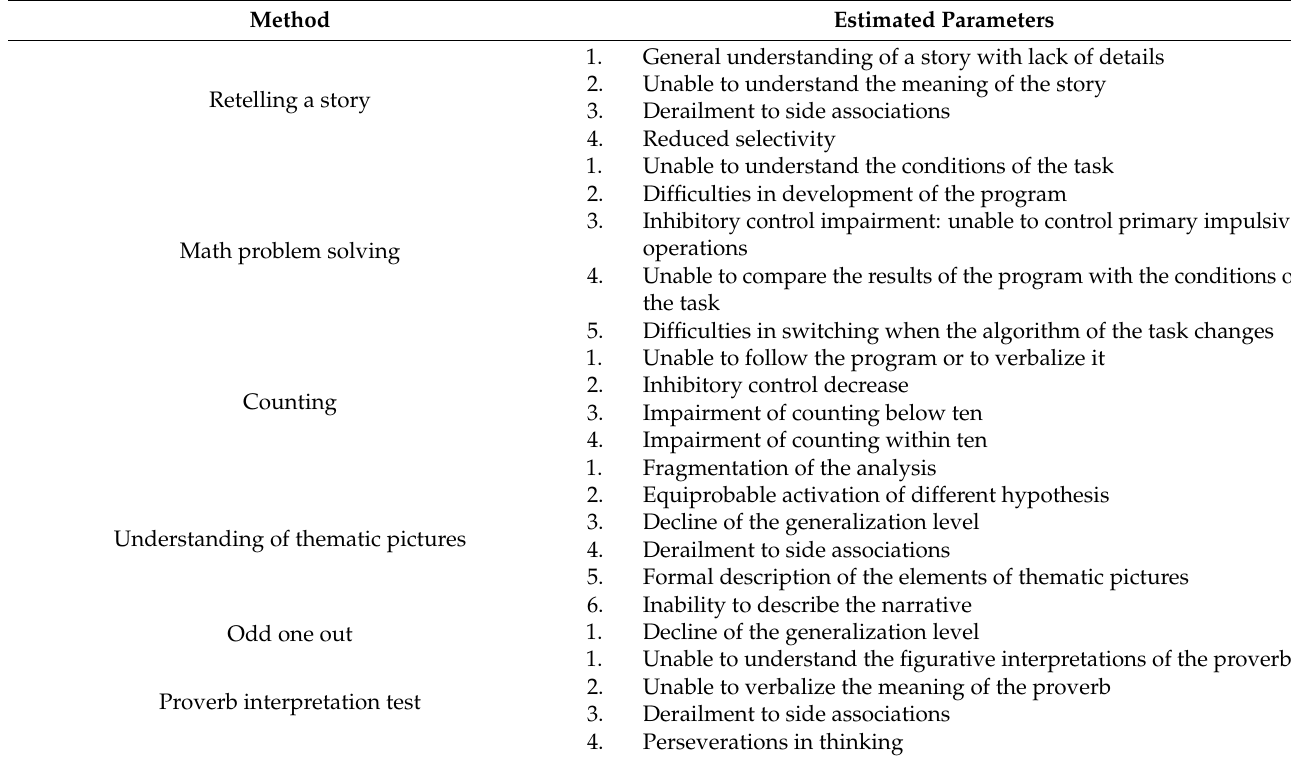
Table 2. List of methods used to evaluate executive functions in line with A.R. Luria’s system, as well as the criteria used to evaluate the